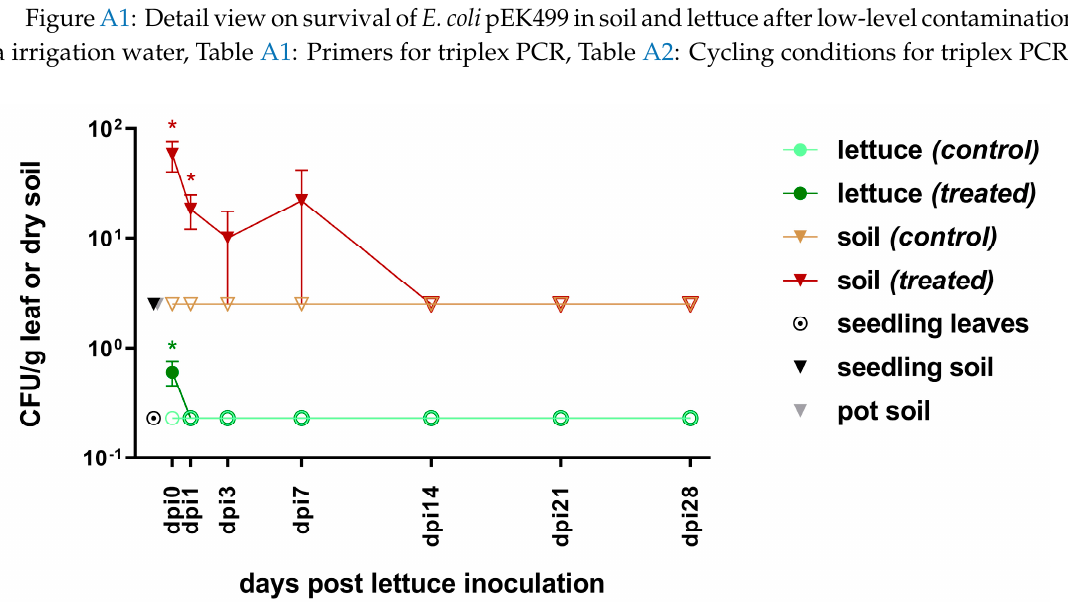
Figure A1. Detailed view on the survival of E. coli pEK499 in soil ( ‐ ▼ ‐ ) and lettuce ( ‐●‐ ) from its introduction until harvest, after low ‐ level contamination via irrigation water. Empty symbols indicate values below the respective limit of detection. Error bars indicate standard error of the mean (SEM, n = 3). Significant differences between treatment and control ( p < 0.05) are marked with an asterisk. Table A1. Primers for triplex PCR detection of aadA5 , bla CTX ‐ M ‐ 15 , and tetA present on plasmid pEK499 and amplification of 16S rRNA gene.